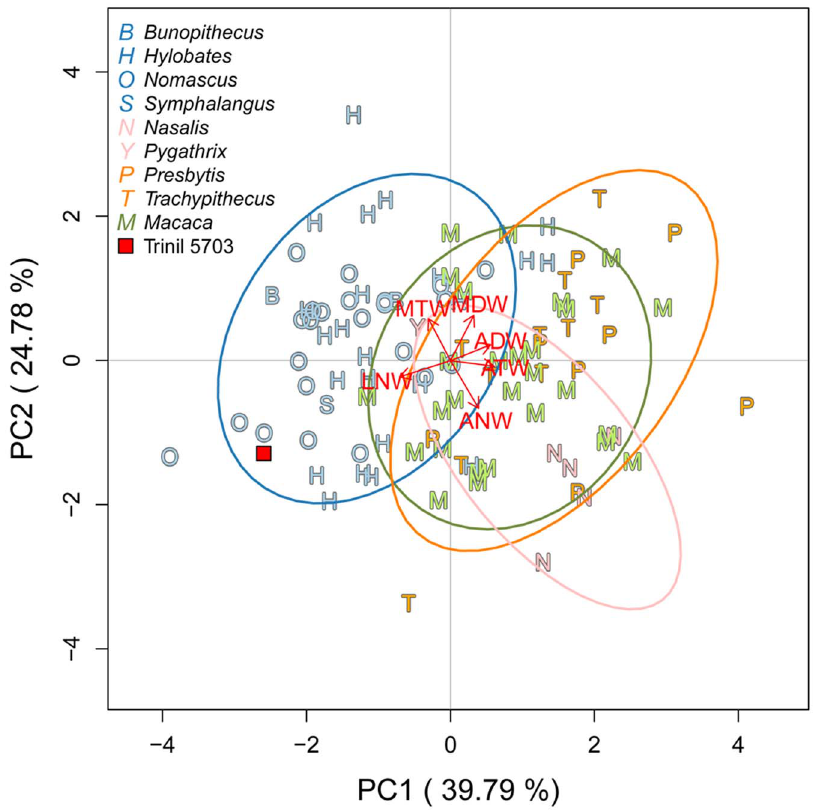
Figure 9. Principal component analysis on log-shape ratios. Presentation conventions are the same as in Figure 7.